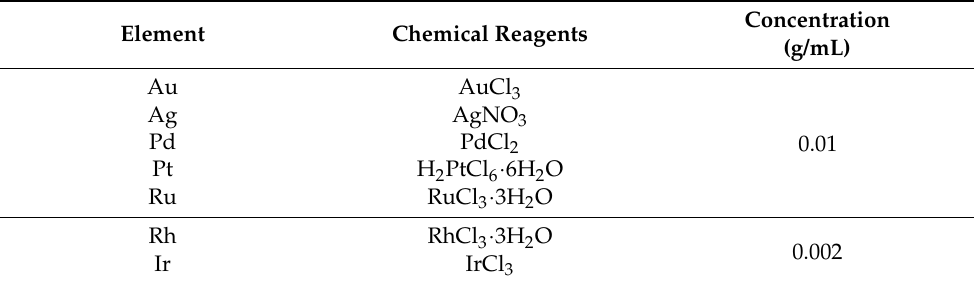
Table 1. Chemical reagents and their concentrations.